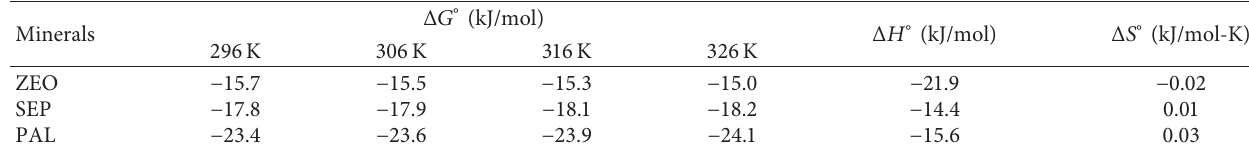
Figure 3: Influence of equilibrium solution pH (a), ionic strength (b), and temperature (c) on SO sorption on PAL, ZEO, and SEP. Table 1: Thermodynamics of SO uptake on PAL, ZEO, and SEP.